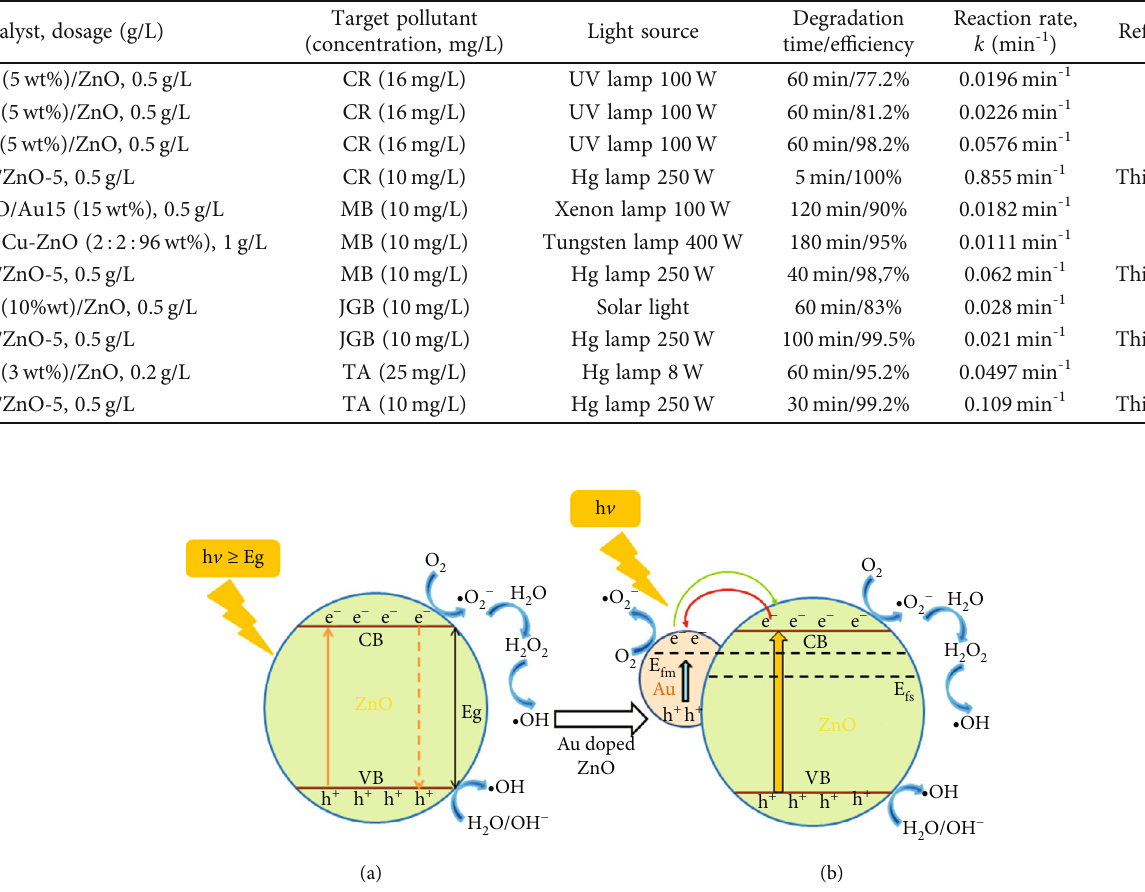
Figure 16: Schematic model for the photocatalytic mechanism of (a) bare ZnO and (b) Au/ZnO